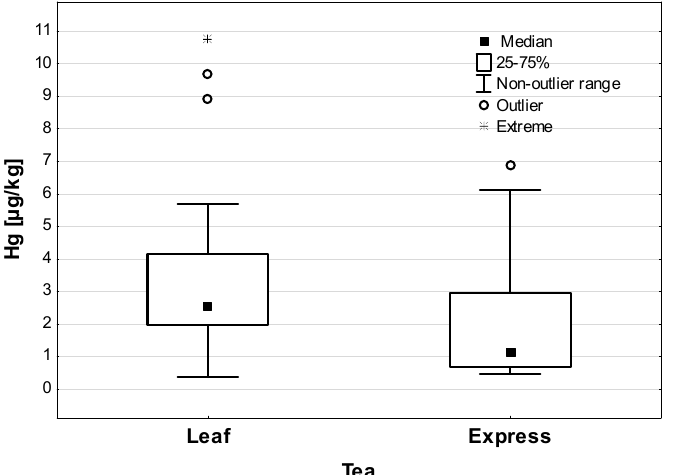
Figure 2. Hg concentration in leaf and express tea ( µ g/kg).